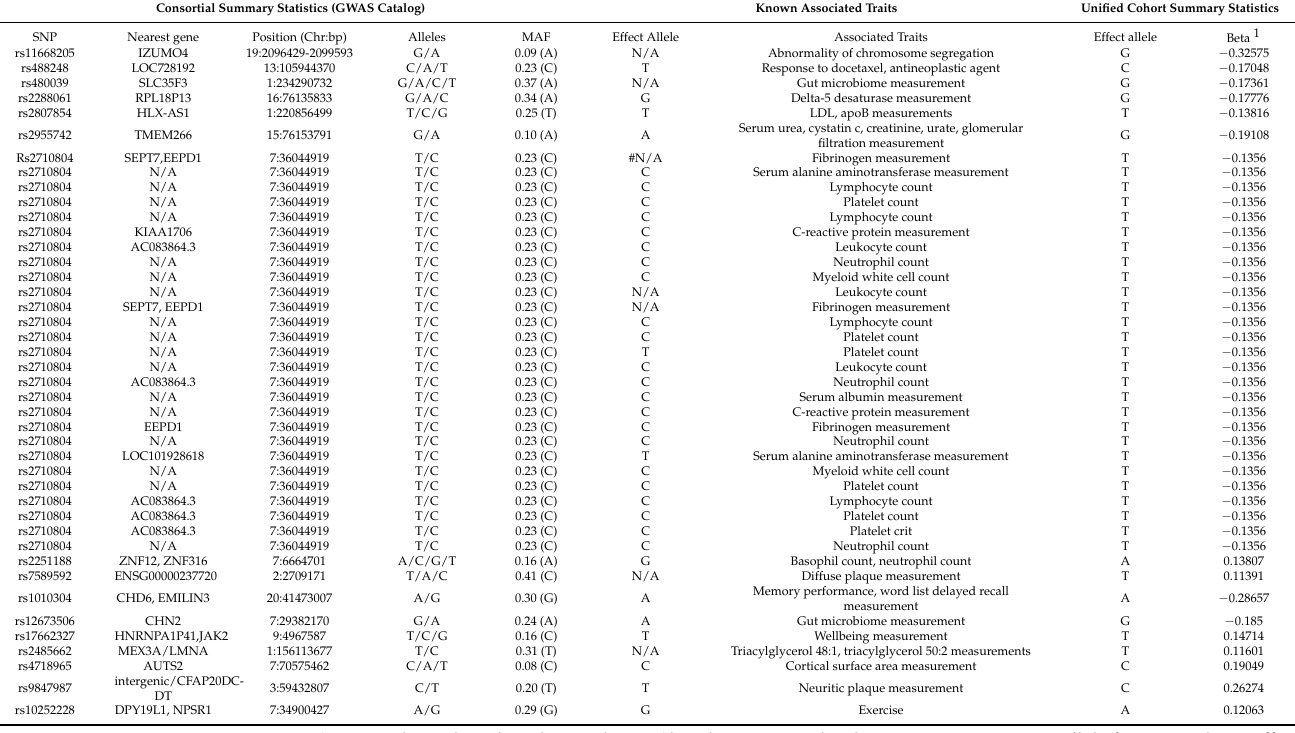
T Responsetodocetaxel,antineoplasticagent C − 0.17048